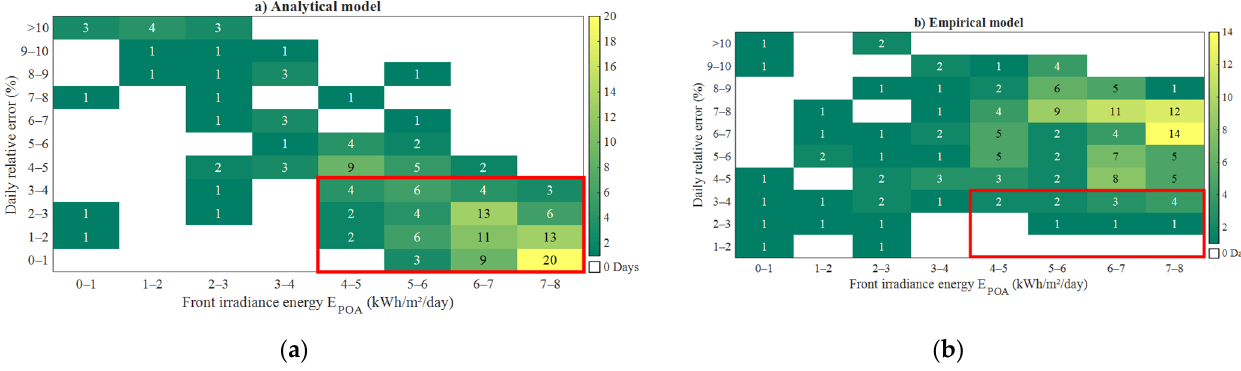
Figure 13. Heatmap of the daily errors of the analytical and the empirical models for bifacial modules with high albedo. ( a ) Daily relative error distribution using the analytical model. ( b ) Daily relative error distribution using the empirical model. The number of days for the analytical model and the empirical model within the highlighted area (limited to EPOA > 4 kWh/m2/day and relative errors < 4%) were 106 and 14, respectively.